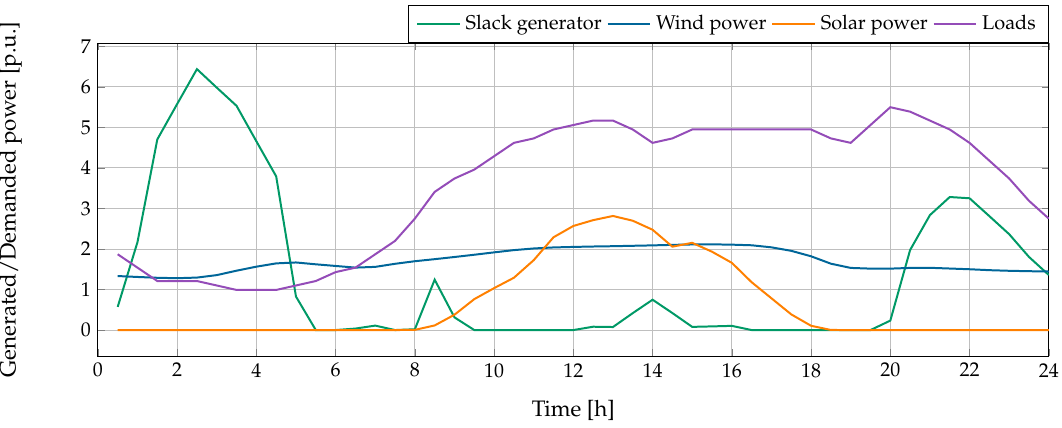
Figure 4. Generated powers for the slack generator, wind and solar power systems, and